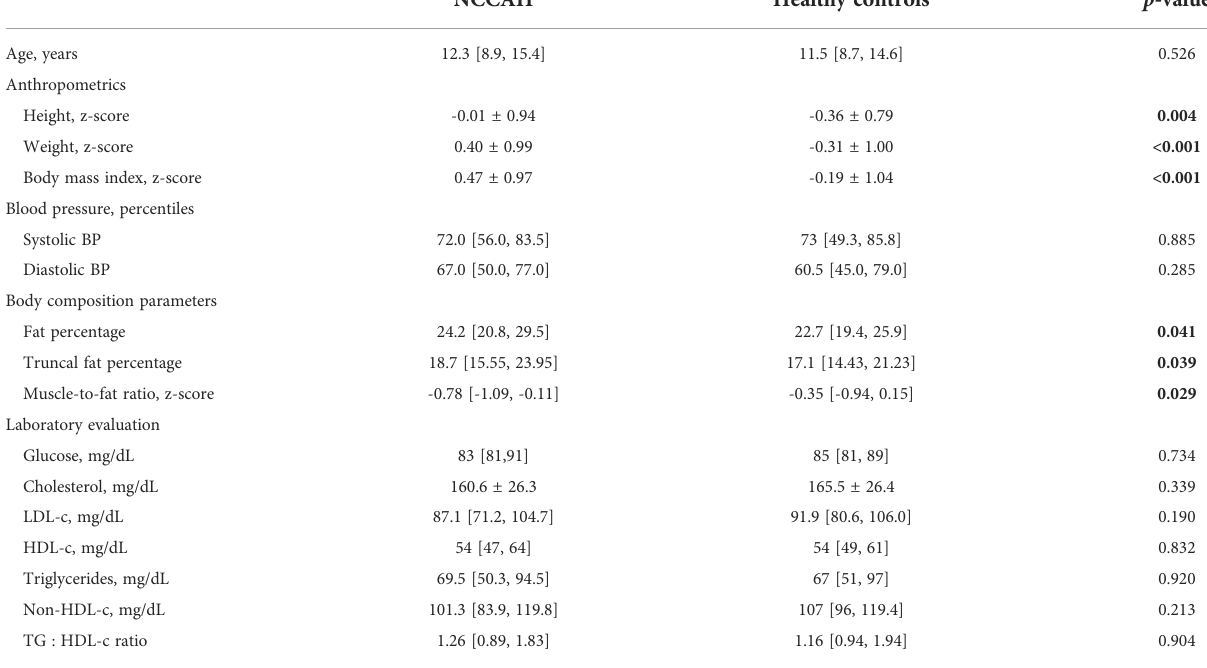
TABLE 3 Clinical and metabolic characteristics of NCCAH and their healthy controls at last BIA